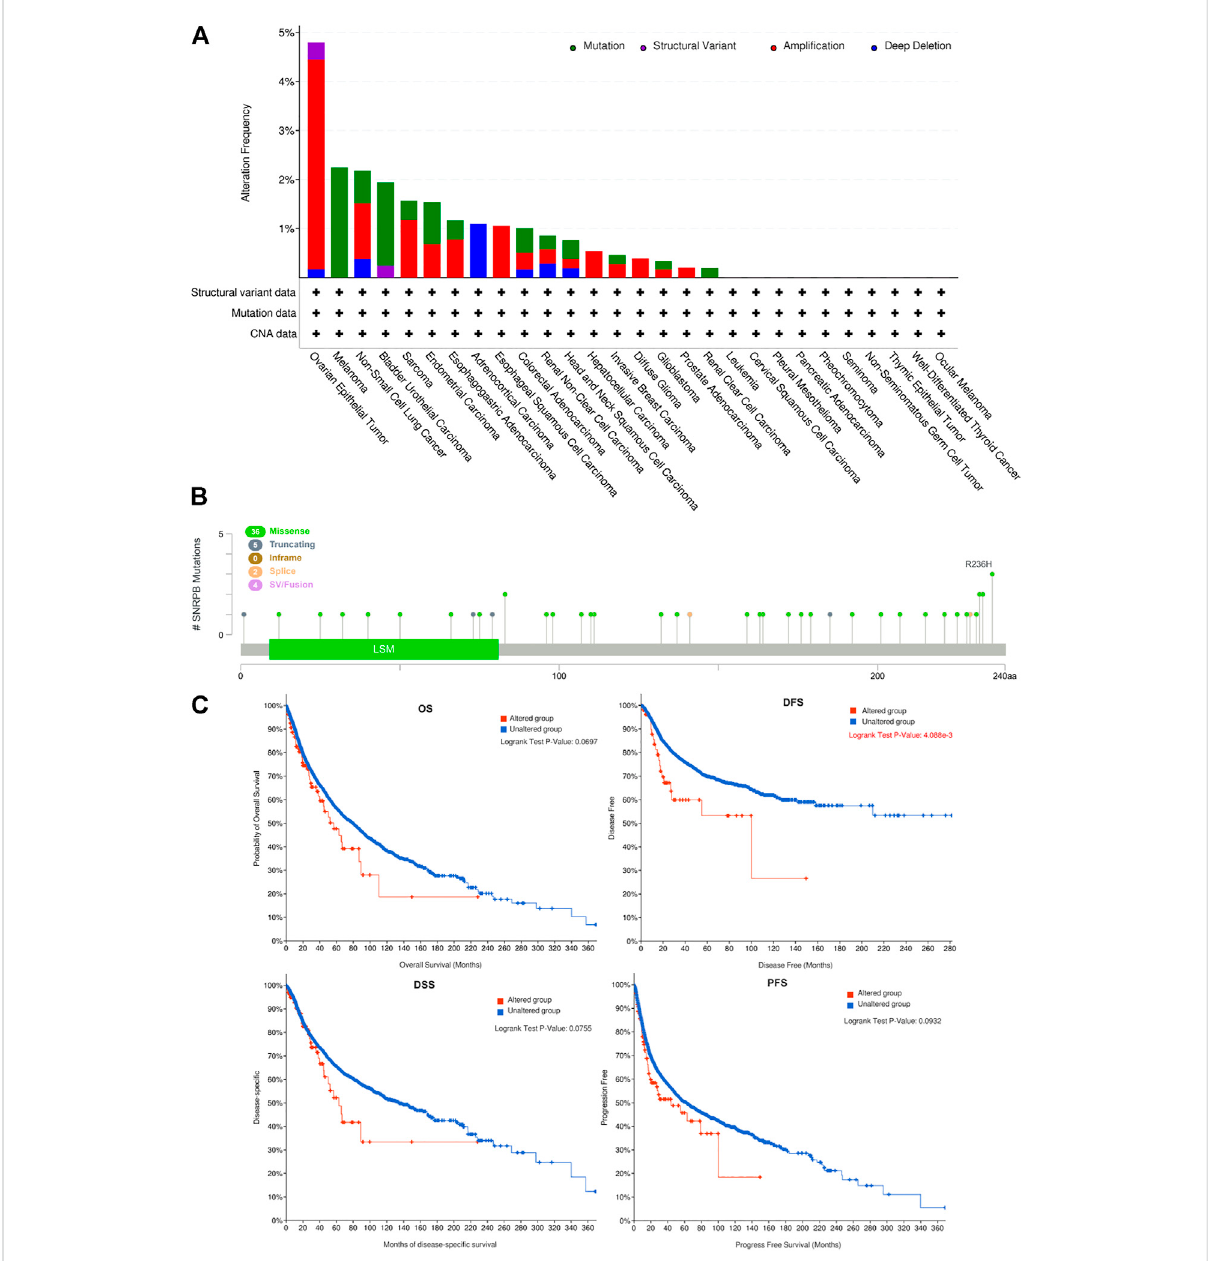
FIGURE 7 Genetic alteration of SNRPB across tumors. (A) . Summary of genetic alterations of SNRPB across tumors. (B) . Mutated SNRPB sites across tumors. (C) . The effect of genetic alteration on OS, DFS, DSS, and PFS across